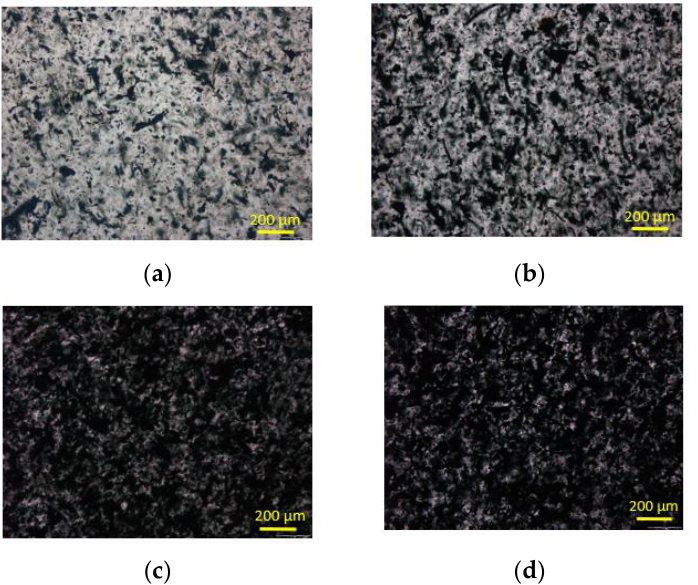
Figure 3. Micrograph of PVB reinforced with G2Nan at 0.5 wt% ( a ), 1 wt% ( b ), 1.5 wt% ( c ) e 2 wt%